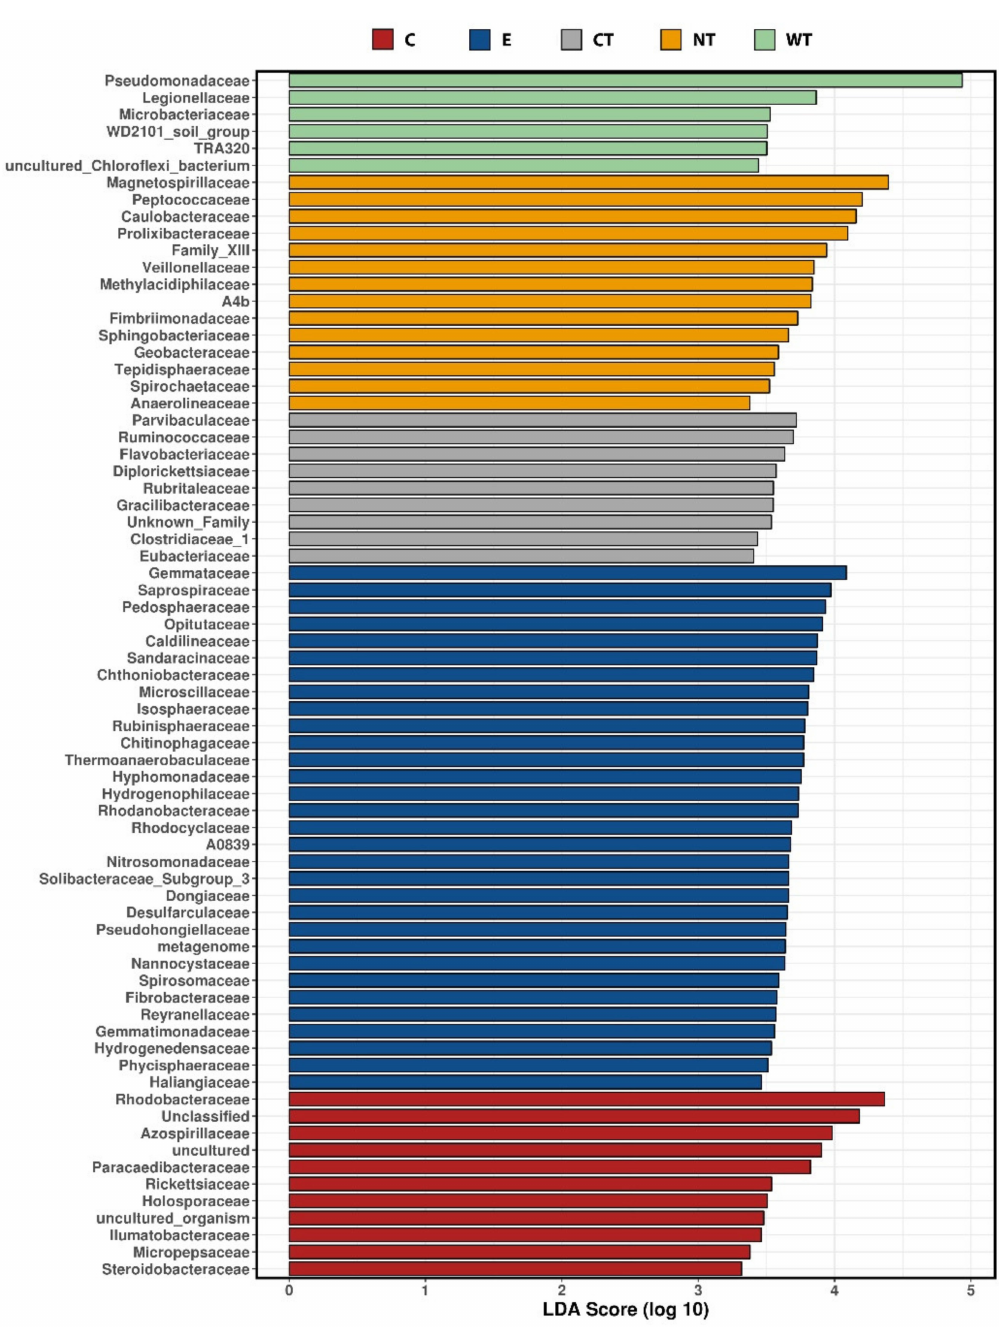
Figure 4. Taxa identified as biomarkers for each treatment by LEfSe analysis, LDA scores (log10) threshold was set to 3. (C: cinnamon; E: ethanol; CT: common thyme; NT: not-treated control; WT: wild